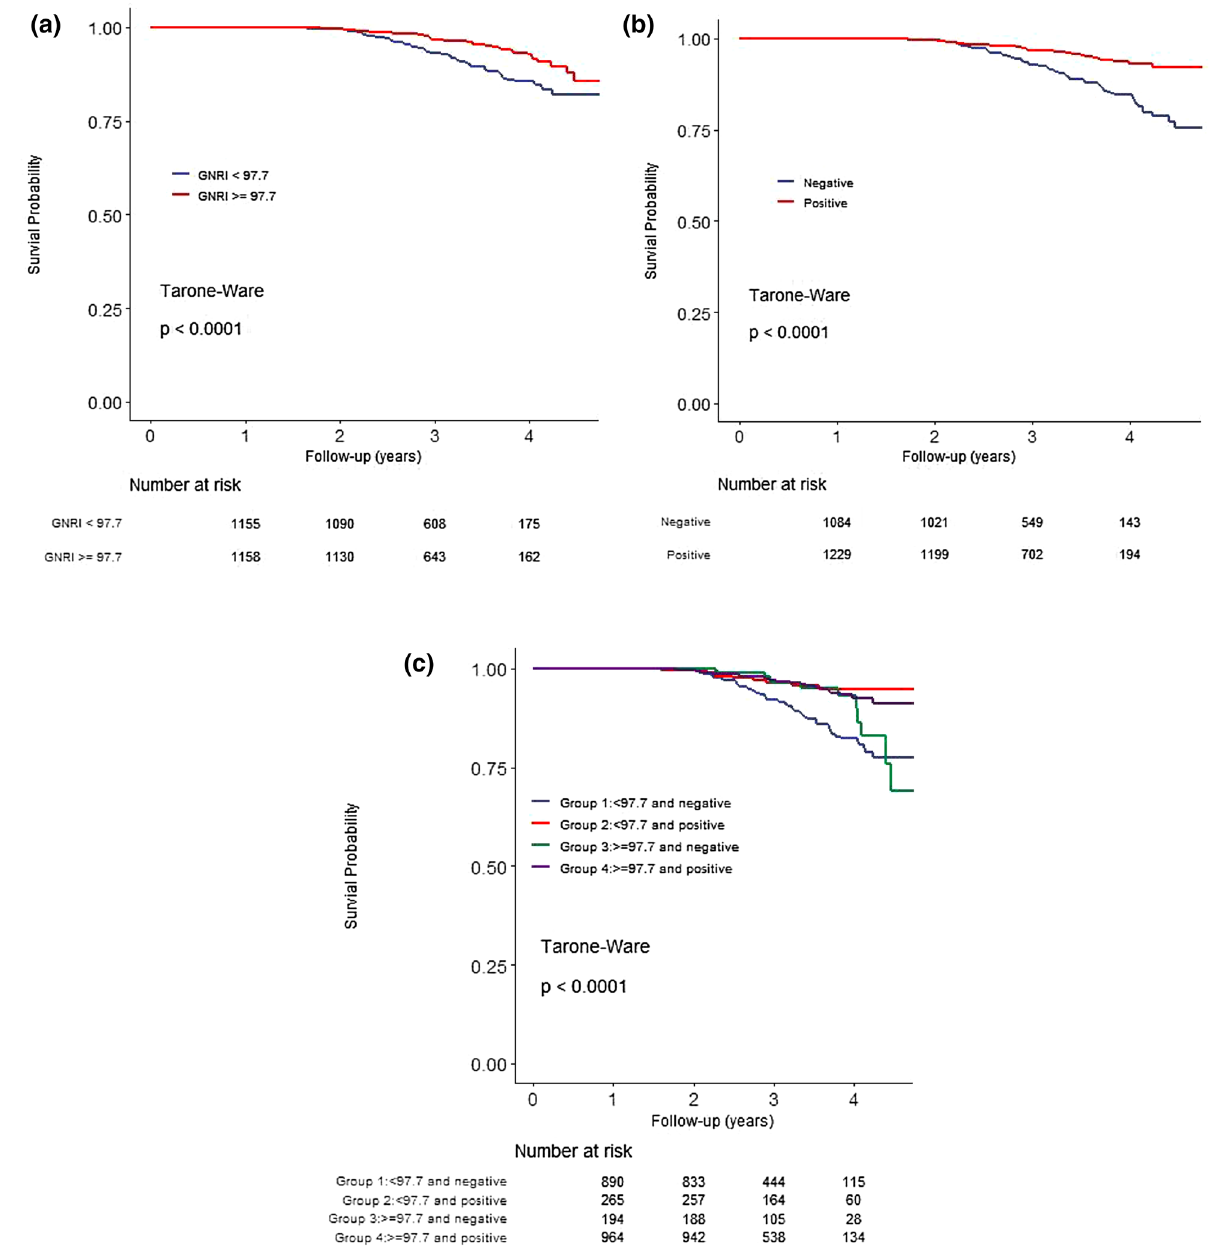
Figure 1. Kaplan–Meier survival curves for all-cause mortality. ( a ) GNRI < 97.7 vs. GNRI ≧ 97.7, ( b ) negative GNRI trend vs. positive GNRI trend, ( c ) Groups divided by baseline GNRI and GNRI trend. Group 1, GNRI < 97.7 and negative GNRI trend; Group 2, GNRI < 97.7 and positive GNRI trend; Group 3, GNRI ≧ 97.7 and negative GNRI trend; Group 4, GNRI ≧ 97.7 and positive GNRI trend. GNRI Geriatric Nutritional Risk